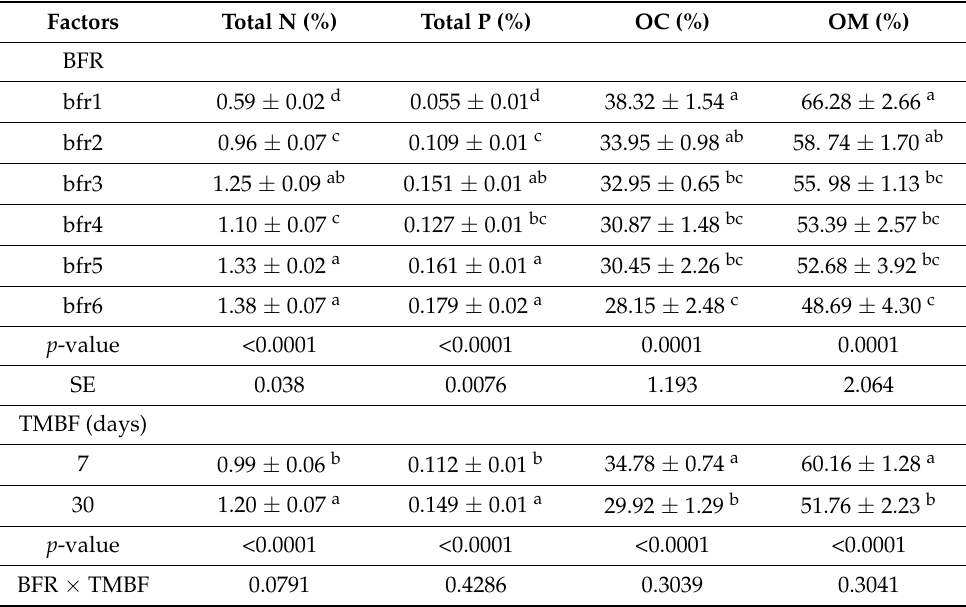
Table 4. Main and interaction effects of bokashi fertilizer ratios and time of bokashi fertilizer matura- tion on total N, total P, OC (%), and OM